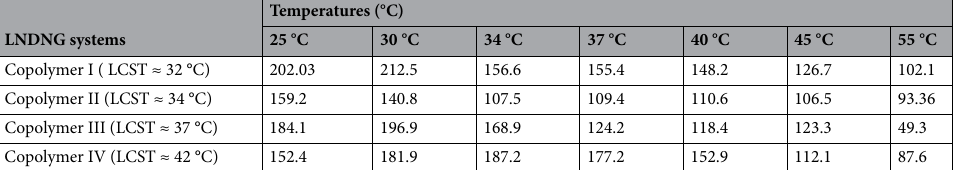
Table 3. Result of DLS data indicating the reduction of nanogel particle size (nm) by increase in temperature. Four LNDNG contain four different copolymer compounds which have their own distinctive LCST behavior across the temperature